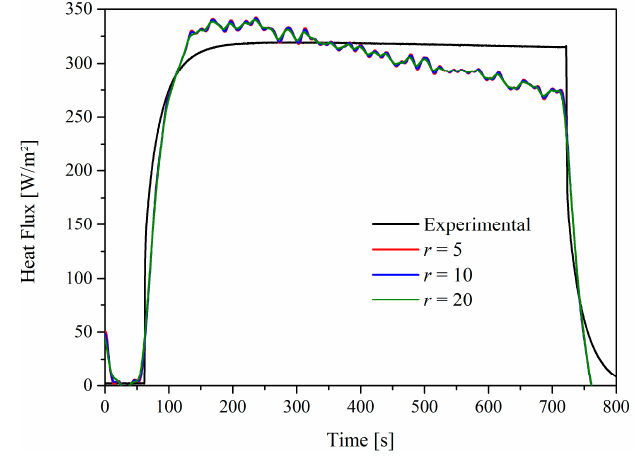
Figure 6. Comparison between the measured and estimated heat flux for Aluminum 5052.